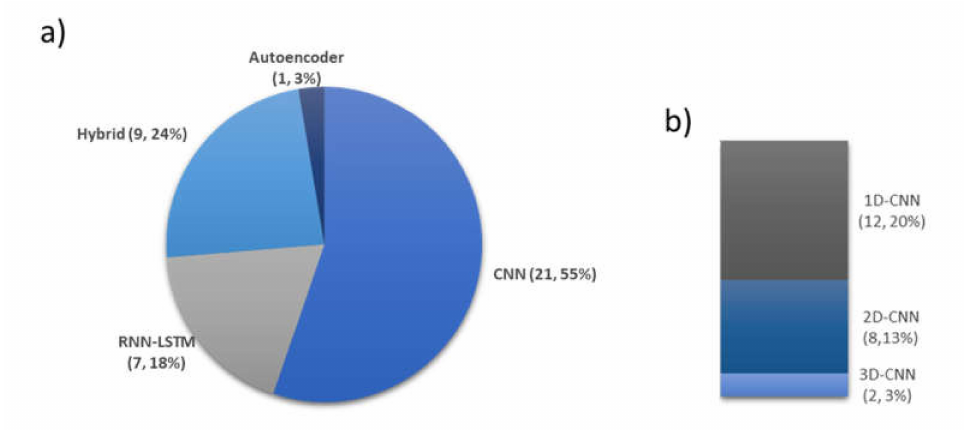
Figure 9. Selection of various DL techniques for automated sleep stage classification based on 36 studies. ( a ) Number of times and percentage of DL models, ( b ) Various CNN-based models. * Summary statistics: using autoencoders versus hybrid versus LSTM versus CNN models (one-dimensional (1D), 2D,